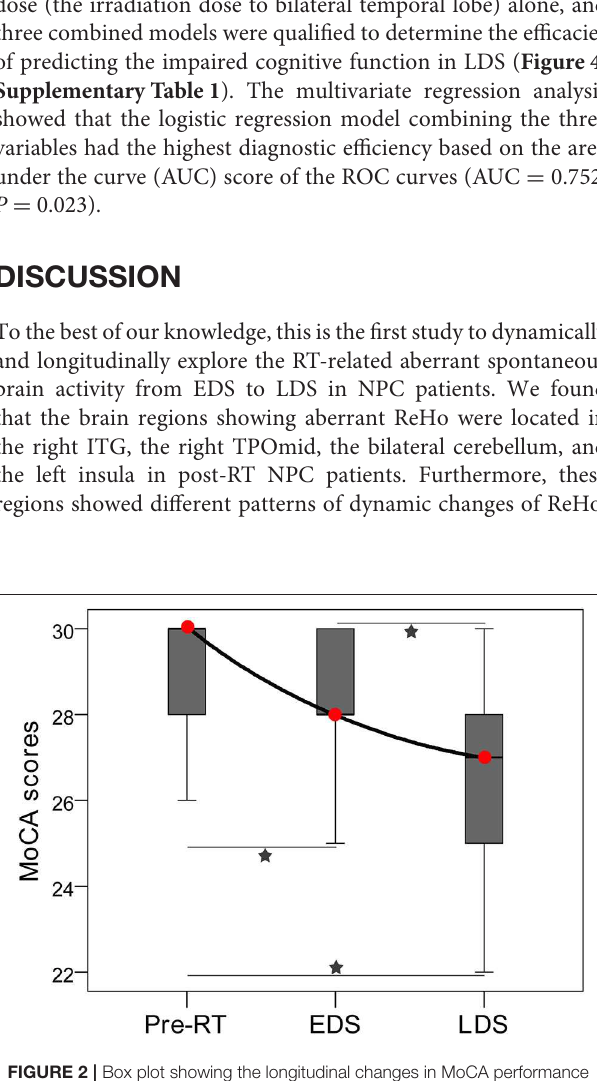
FIGURE 2 | Box plot showing the longitudinal changes in MoCA performance of patients with nasopharyngeal carcinoma. A significant decrease in the MoCA scores was detected among the three stages; there were significant differences in MoCA scores between pre-RT and EDS, between Pre-RT and LDS, and between EDS and LDS. Red circles indicate median MoCA scores of each stages. Pentagrams indicate significant differences with post-hoc Dunnett’s tests ( P < 0.05). EDS, early-delayed stage; LDS, late-delayed stage; MoCA, Montreal Cognitive Assessment; RT, radiation